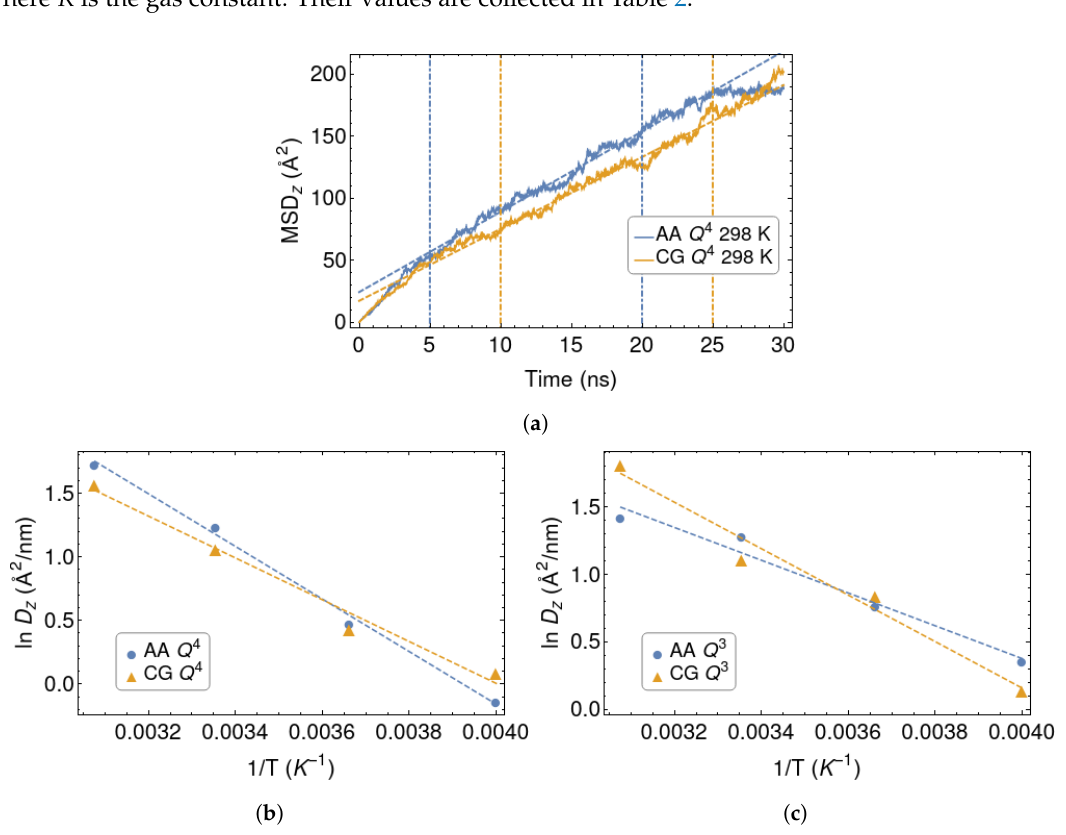
Figure 5. ( a ): Mean-square displacement in the z direction for the CG and AA Q 4 silica surface. Vertical dashed lines delimit the range considered in the linear fits. ( b , c ) Diffusivities of the polymer chains in the orthogonal direction, for the Q 4 and Q 3 silica walls. Arrhenius fits are shown as dashed lines. Table 2. Activation energies related to the polymer diffusion in the z